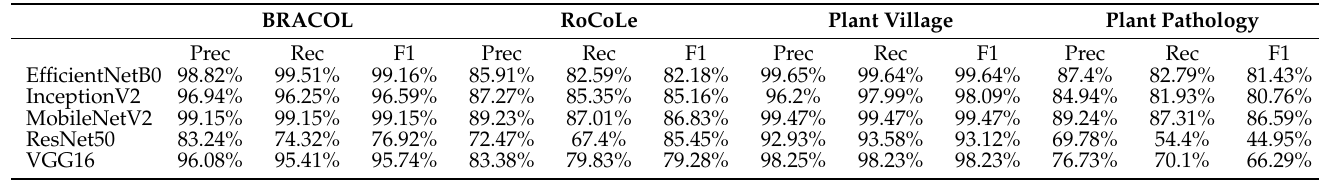
Figure 2. Comparison in terms of convergence speed and training accuracy. In the first column, we report laboratory datasets: ( a ) BRACOL, ( c ) Plant Village. In the second column, we report field datasets: ( c ) RoCoLe, ( d ) Plant Pathology. Table 6. Recall, Precision, F1 score obtained on test